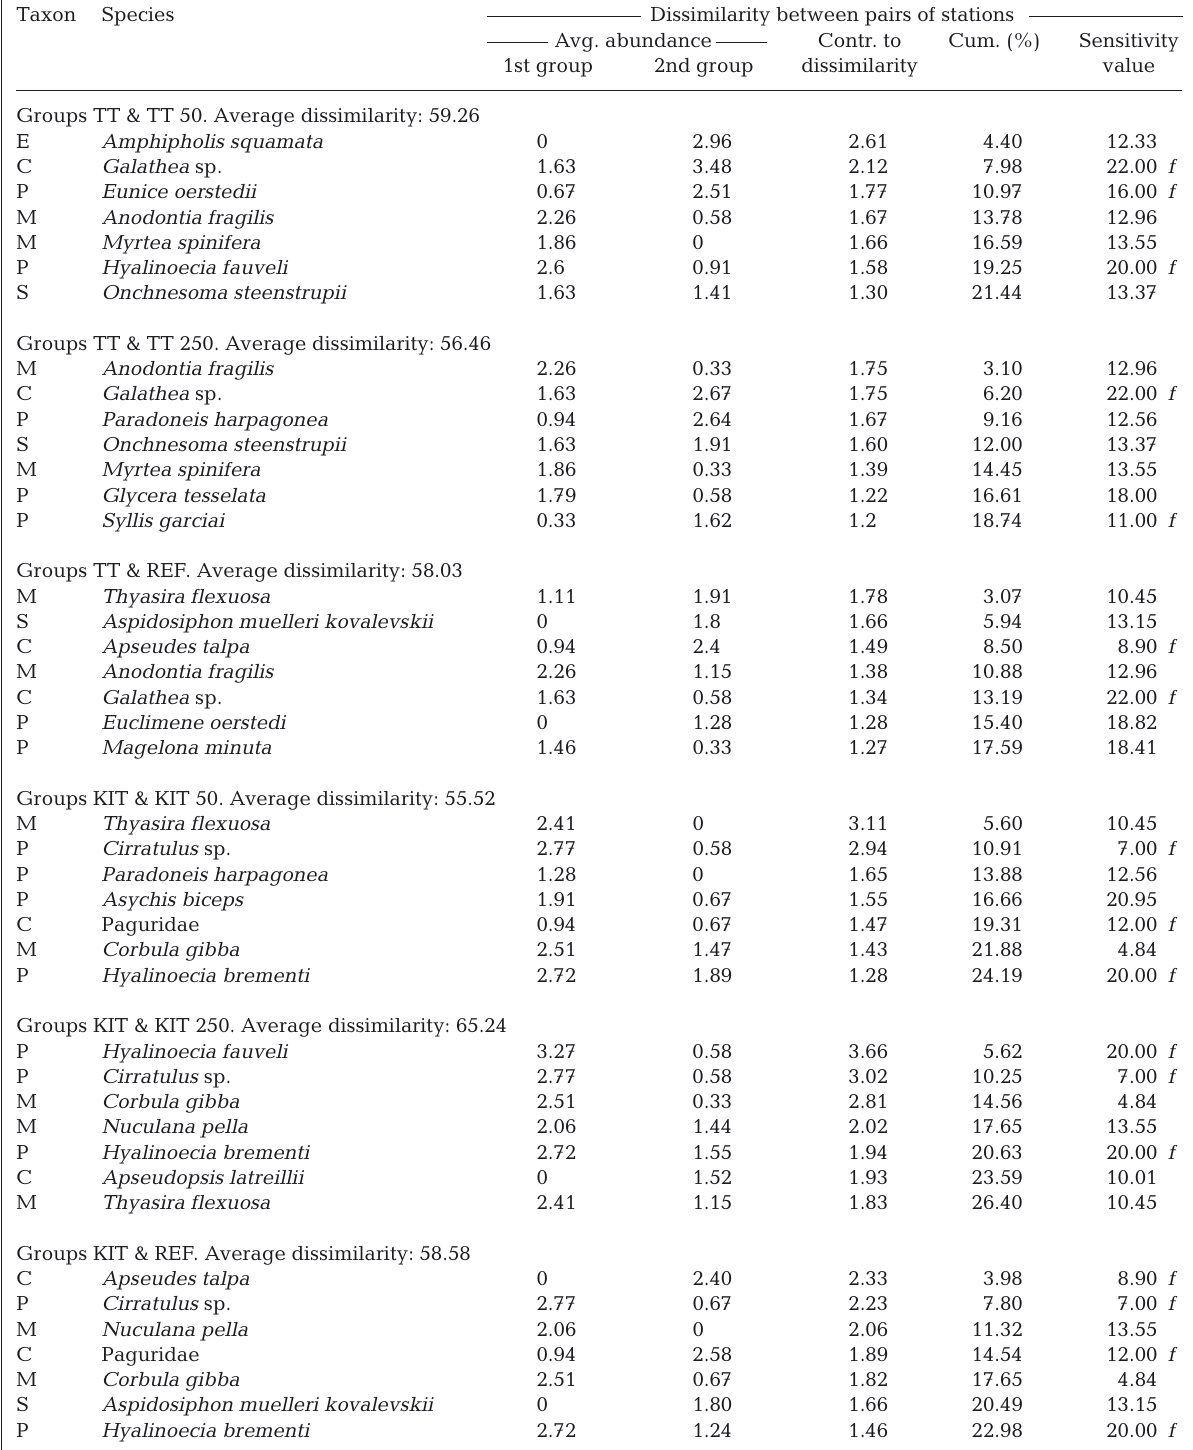
Table 4. SIMPER analysis results performed on total sieve data (in each comparison only the 7 species contributing most to the dissimilarity are shown). Average abundance and percentage contributions of each species to dissimilarities between pairs